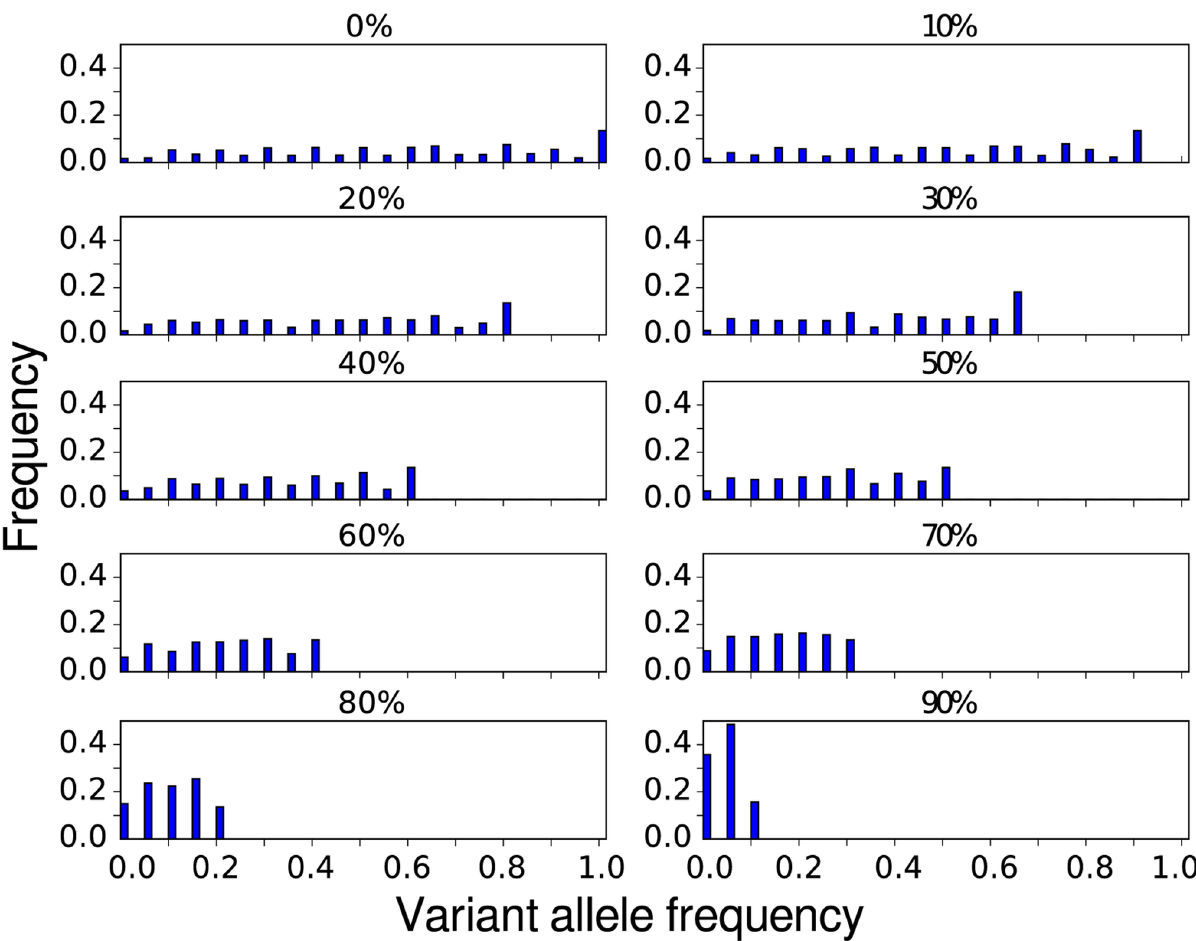
Fig 2. Histograms of true allele frequencies in each tumor sample. Note how increasing admixtureincreasesthe prevalence of low- frequency variants.